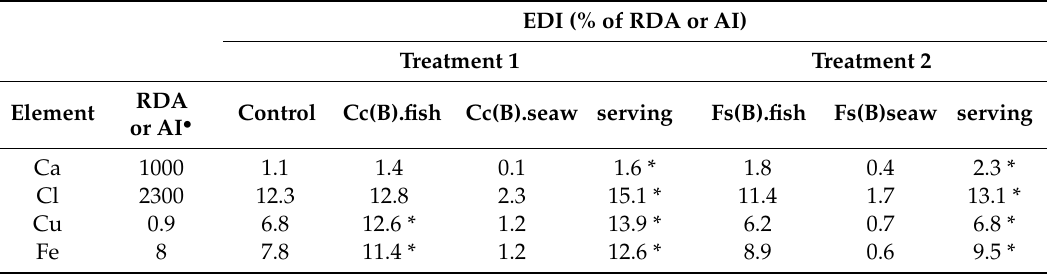
Table 3. Recommended dietary allowance (RDA; mg / d) or adequate intake (AI; mg / d) and contribution (%) of the estimated daily mineral intake (EDI) to RDA or AI derived from the consumption of canned mackerel incorporating C. crispus (Cc(B).fish) or F. spiralis (Fs(B).fish) prepared under Trial B